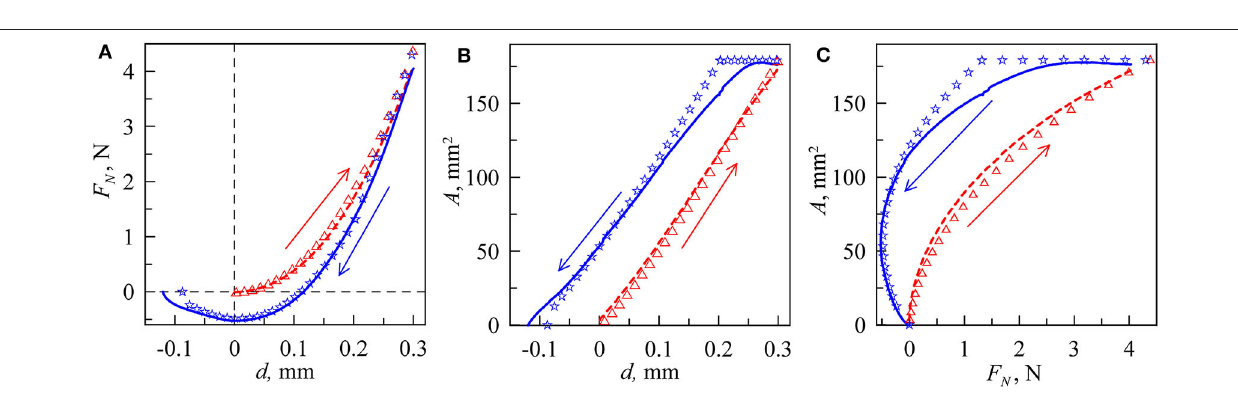
with the value γ 12 = 0.9 J/m 2 . These results are shown in Figure 4A with stars. The situation of indentation without adhesion and detachment with adhesion is similar to the case presented in Figure 3 in Ciavarella et al. (2019). When the direction of motion is changed from indentation to pull-out, the contact area remains constant for some time, similar to what was observed in Waters and Guduru (2010). Such type of experimental behavior can be explained within the framework of the approach of “chemical heterogeneity” of the contact area (Popov, 2020). In Figure 5 , the dependencies of normal force F N vs. indentation depth d for indenters with different roughness are shown (see also Supplementary Video 1 ). As can be seen,